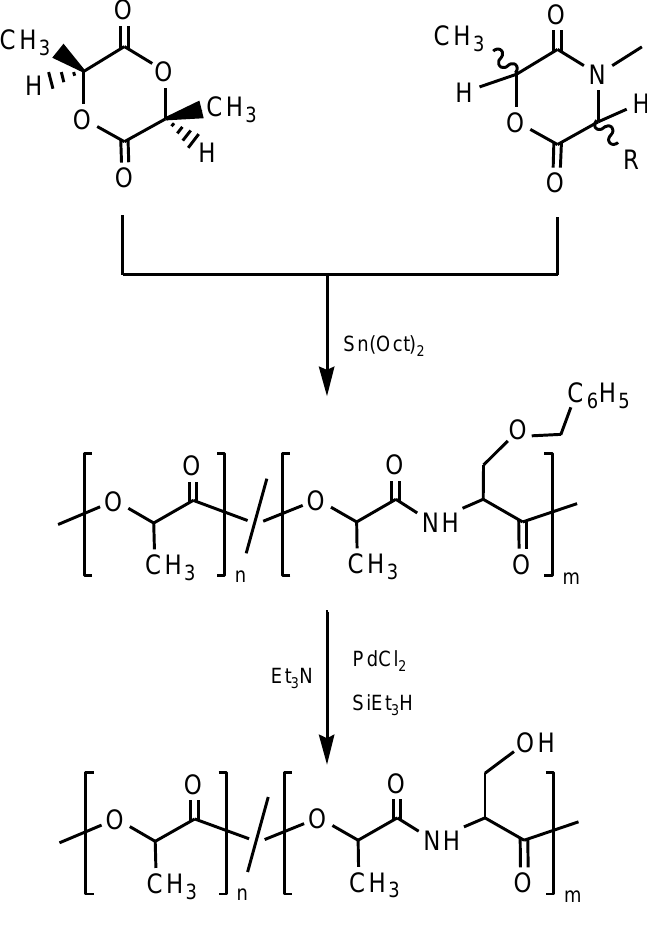
Figure 9. Synthesis of copolymers from L-lactide and a morpholine-2,5-dione derived from L-lactide and protected